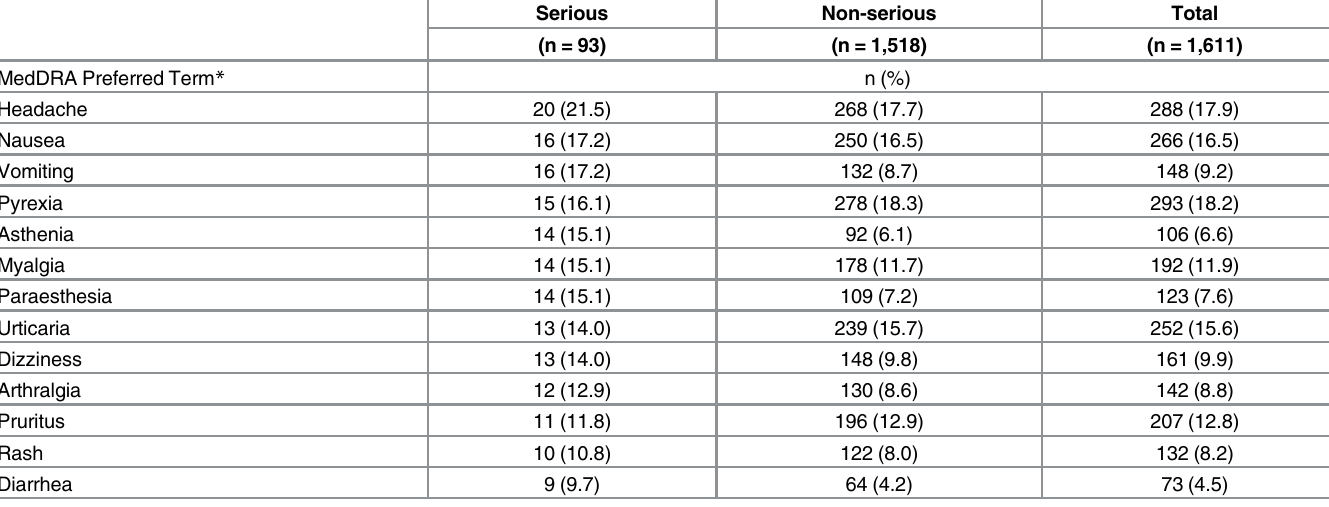
Table 3. Most frequent MedDRA PT codes after rabies vaccine (HDCV, Imovax) in serious † and non-serious reports in VAERS among person vacci- nated January 1, 1990 through July 31,